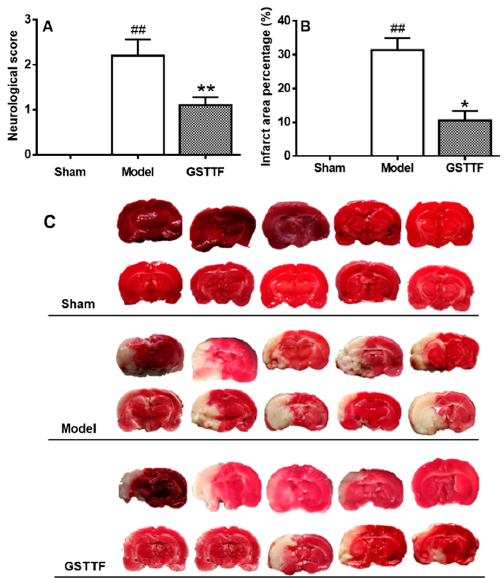
Figure 1. Effects of GSTTF on MCAO rats, neurobehavioral score ( A ), infarct area ( B ) and TTC staining of brain ( C ). ## p < 0.01, the model group versus the sham group; * p < 0.05, ** p < 0.01, the GSTTF-treated group versus the model group.